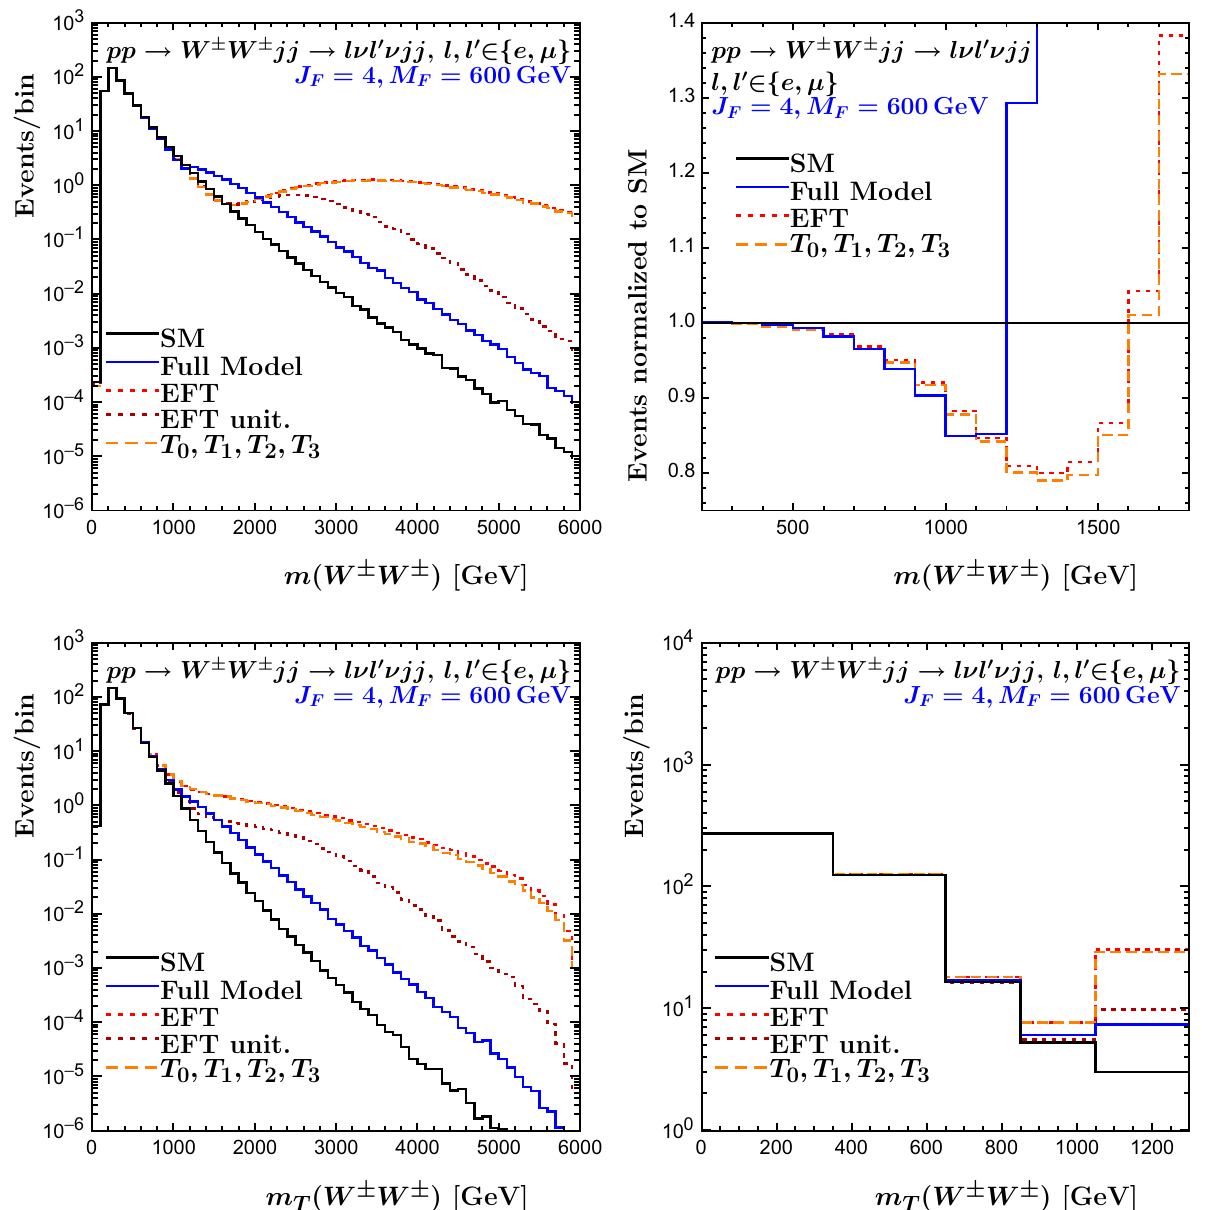
Fig. 11 WW invariant mass (upper row) and llp miss is normalized to the SM. Bin width in the two left panels is 100GeV, transverse mass T while on the lower right bin size is chosen as in Ref. [3]. The considered (lower row) distributions for VBS production of same-sign WW jj scenario is a fermionic multiplet with J F = 4 and M F = 600GeV events at the LHC. Three panels show expected event numbers per bin for a run 2 integrated luminosity of 137fb − 1 while the upper right panel